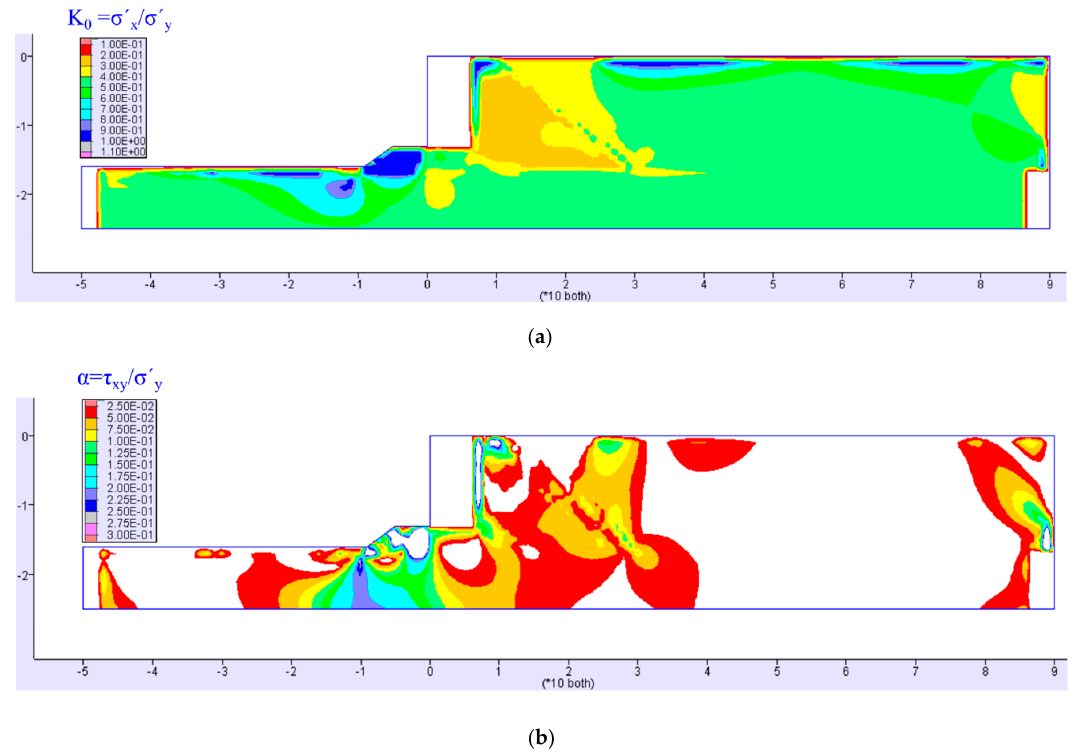
Figure 17. Initial stress state at the start of the earthquake. ( a ) Initial horizontal stress ratio (K 0 = σ´ x /σ´ y ) contours (dimension unit in meters); ( b ) initial static shear stress ratio ( α = τ xy / σ´ y ) contours (dimension unit in meters).